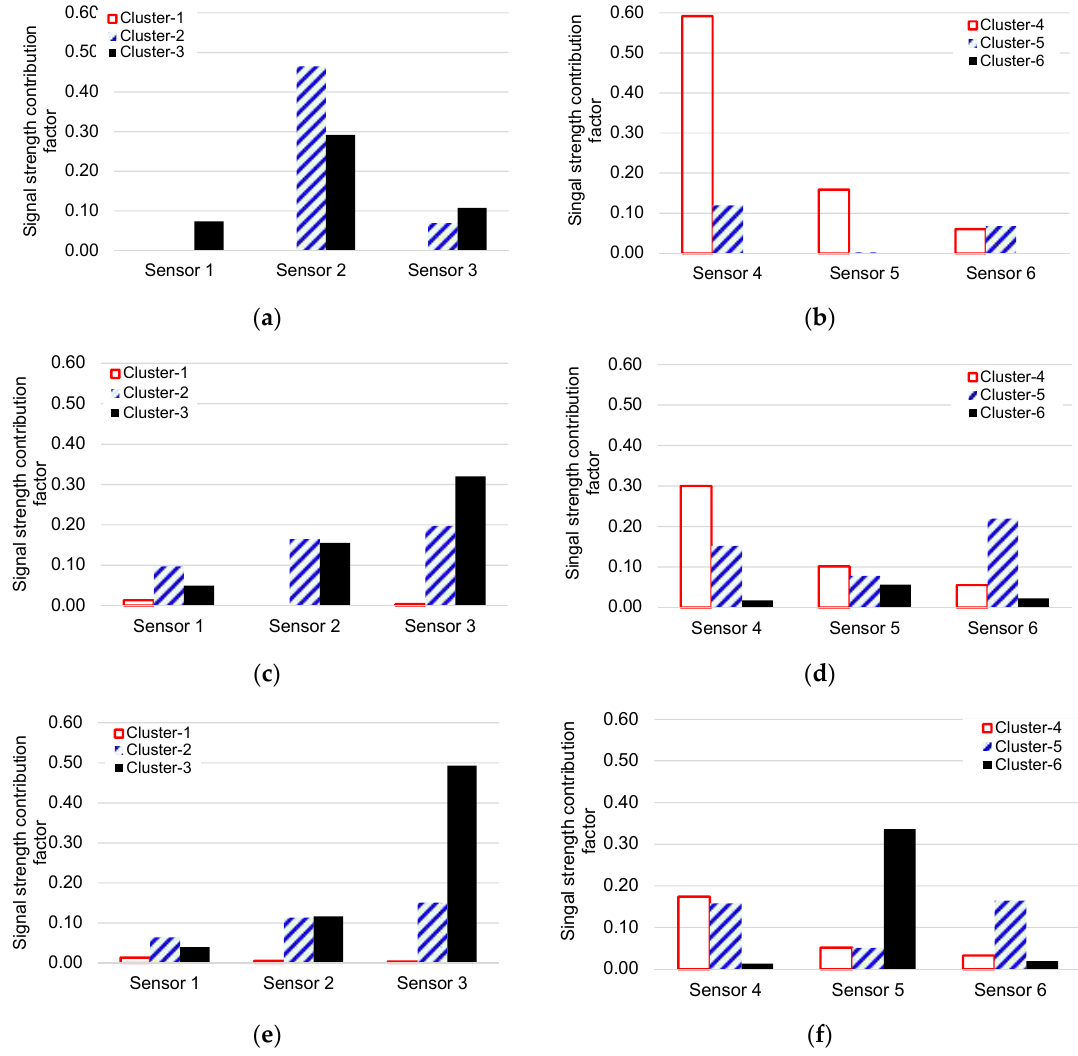
Figure 12. Distribution of total AE signal strength in terms of clusters and sensors. ( a ) Confined specimen at age of 66 days; ( b ) Unconfined specimen at age of 66 days; ( c ) Confined specimen at age of 150 days; ( d ) Unconfined specimen at age of 150 days; ( e ) Confined specimen at age of 195 days; ( f ) Unconfined specimen at age of 195 days.